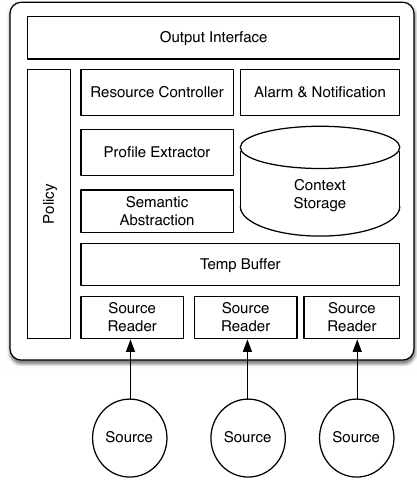
Figure 1. Components of the proposed context sensing and prediction